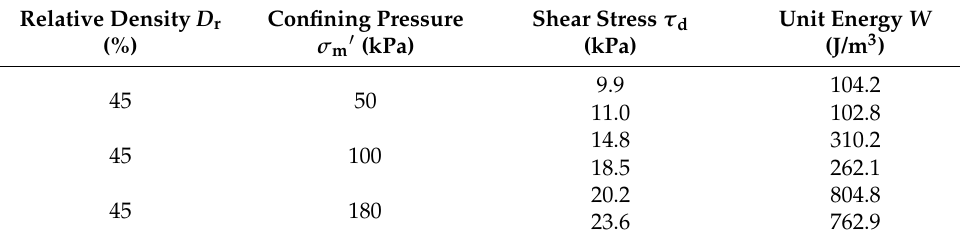
Table 7. Summary of unit energy (J/m 3 ) required for liquefaction. Relative Density D